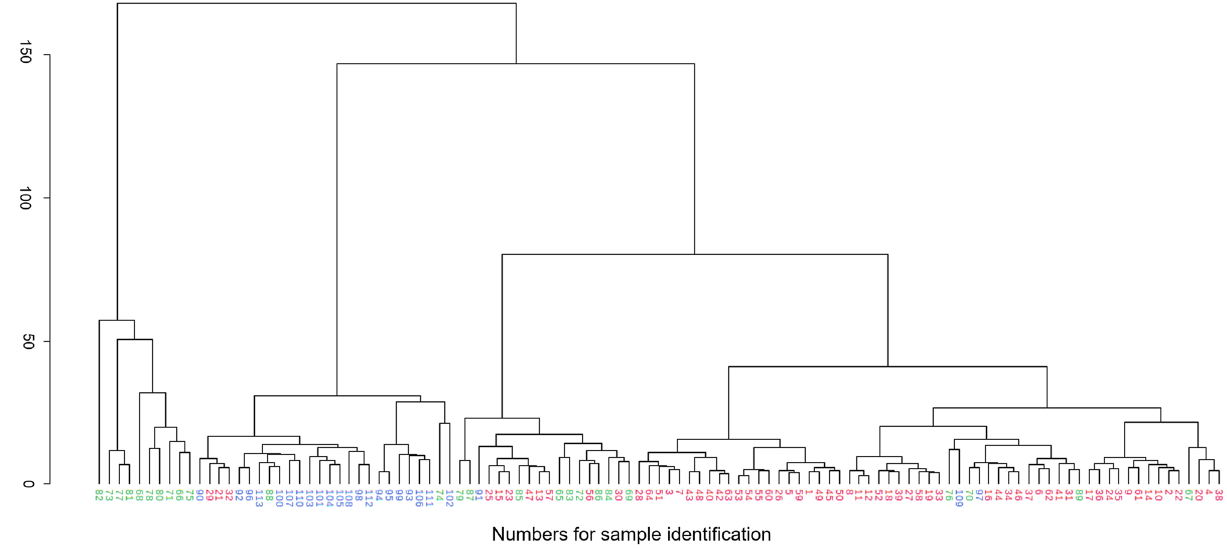
Figure 6. Dendrogram of hierarchical cluster analysis of serum metabolomic results from dogs with cPSS (blue, n = 24), HLEA (green, n = 25), and the combined Control group (red, n = 64). Each number on the x-axis reflects a serum sample. The y-axis shows the similarity levels expressed as Euclidean distances. Horizontal and vertical lines depict clustering of samples and differences of the distances, respectively.